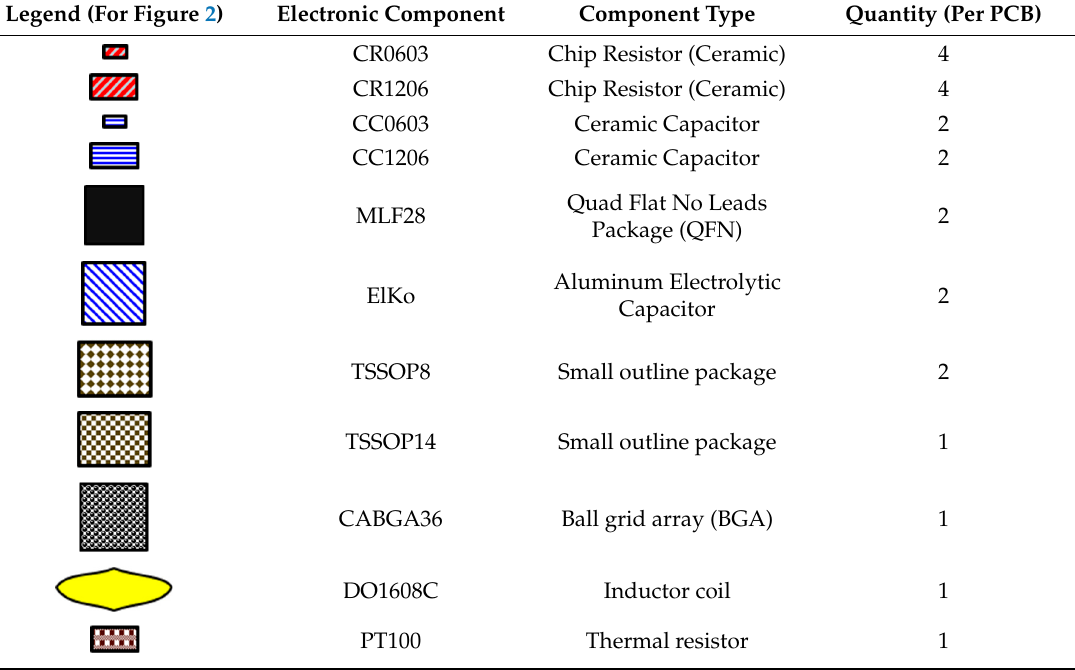
Table 2. Process parameters for the injection molding simulation. Parameter